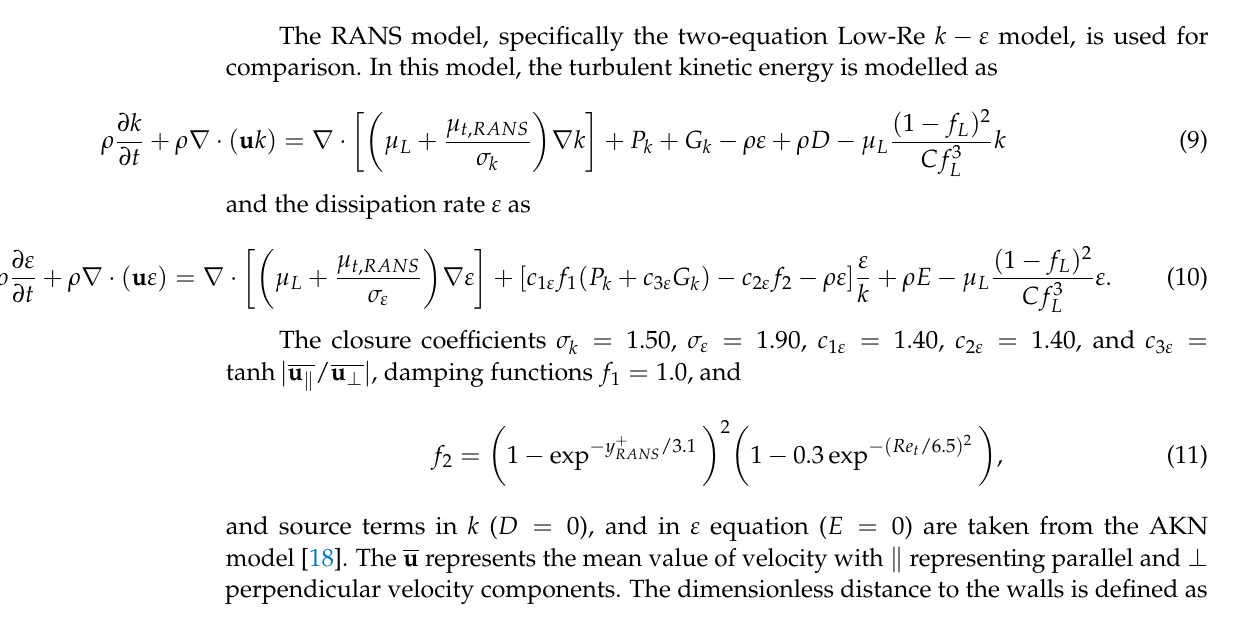
The turbulent Reynolds number